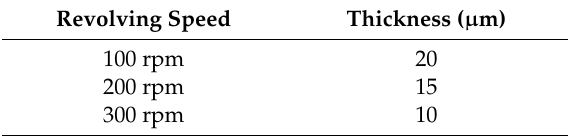
Table 3. Variation of the coating thickness with the spinning speed.